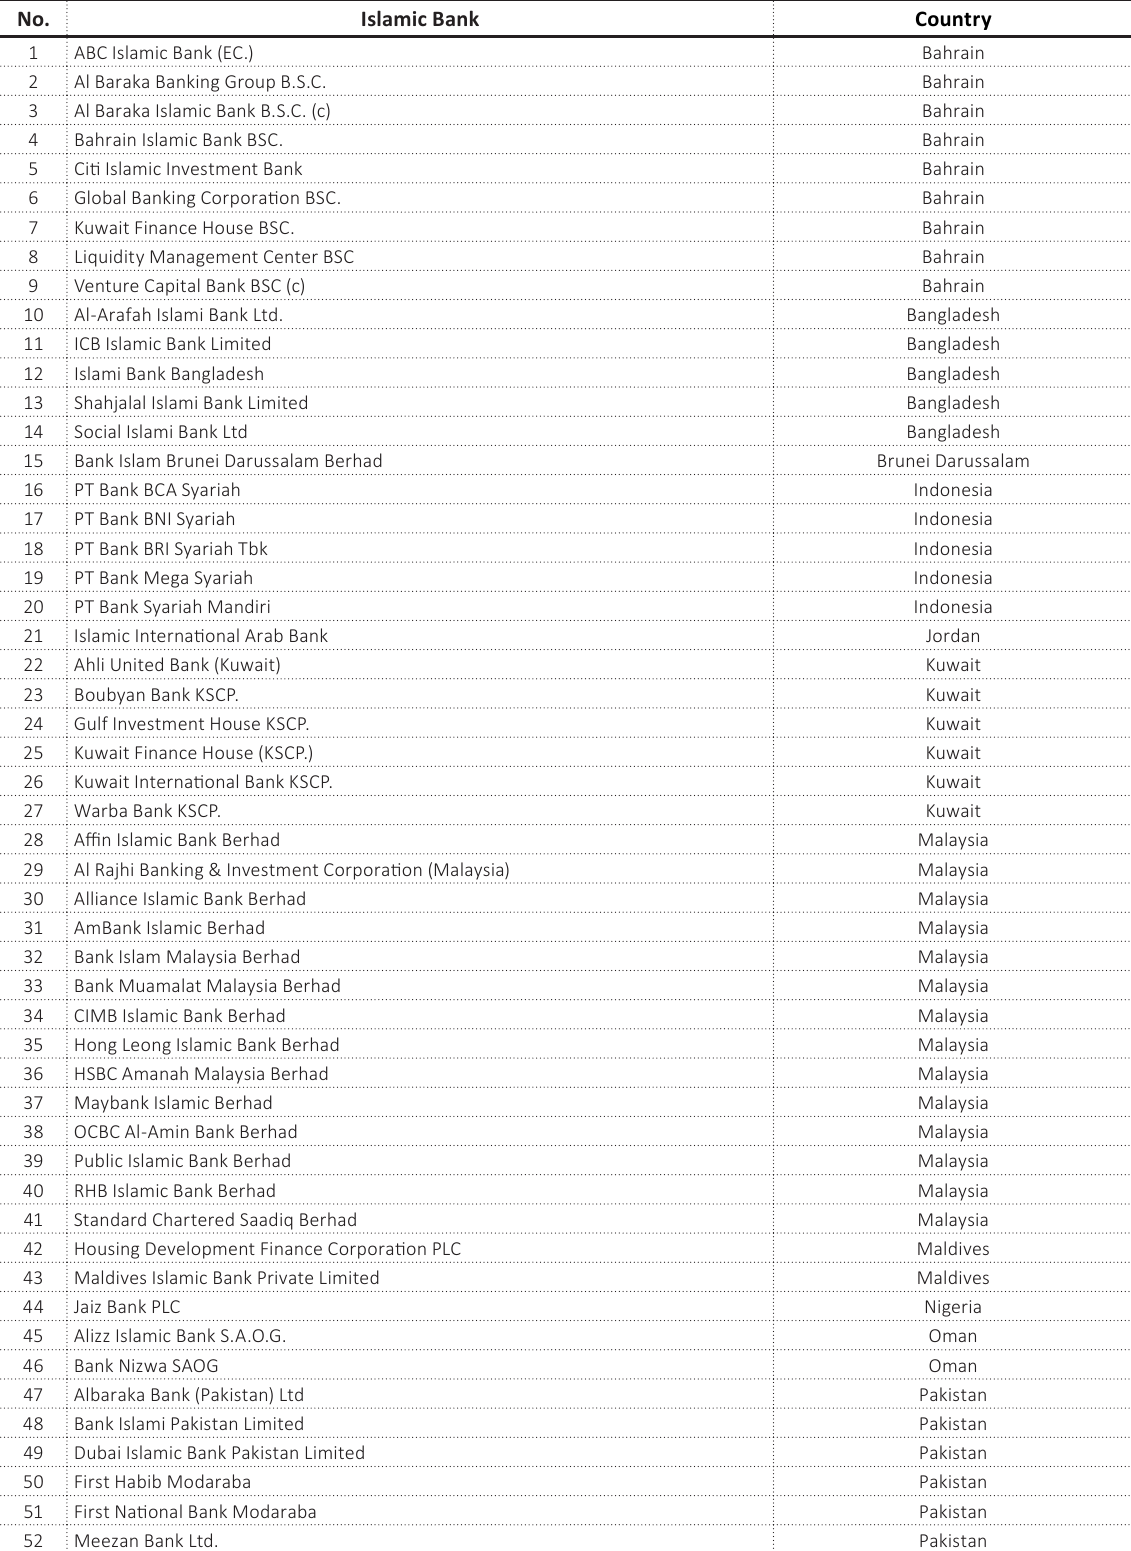
Table A1. List of sample Islamic